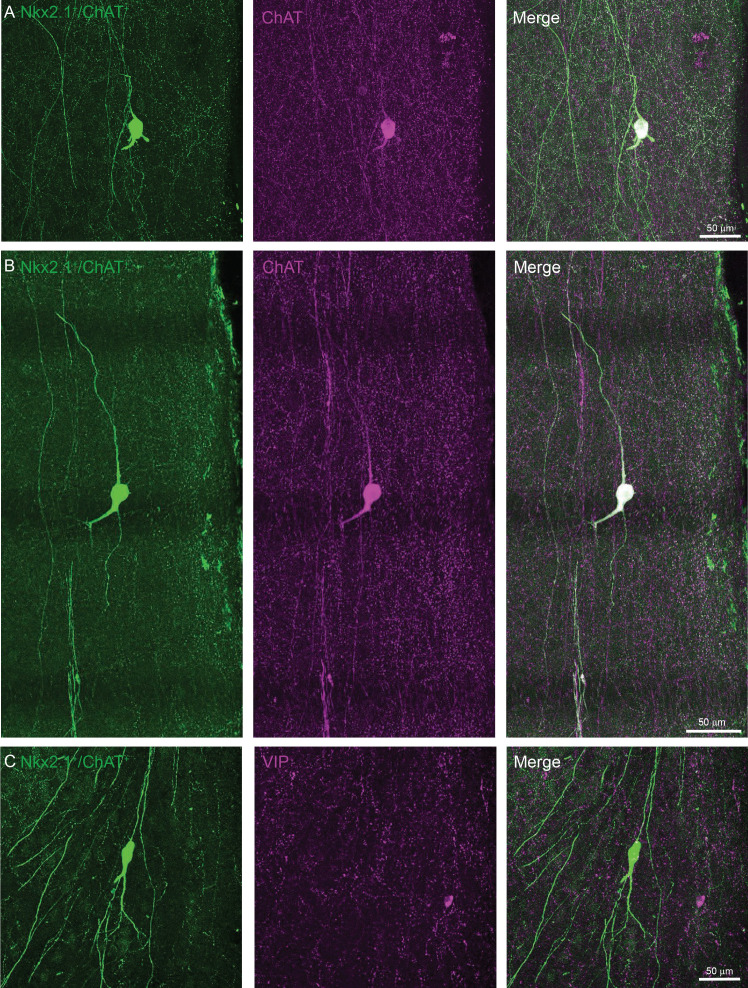
Example images of Non-VIP, ChAT+/Nkx2.1+ neurons in the mPFC.(A,B) Examples of Nkx2.1+/ChAT+ neurons (Chatires-Cre x Nkx2.1ires-FLP x RC::FLTG, left panels) that colabel with immunostained ChAT (middle panels), demonstrating distinctive morphology of non-VIP, ChAT+ neurons. Superficial surface of the mPFC is aligned to the right in each image. (C) Example of a Nkx2.1+/ChAT+ neurons (left panel) that does not colabel with immunostained VIP (middle panel).